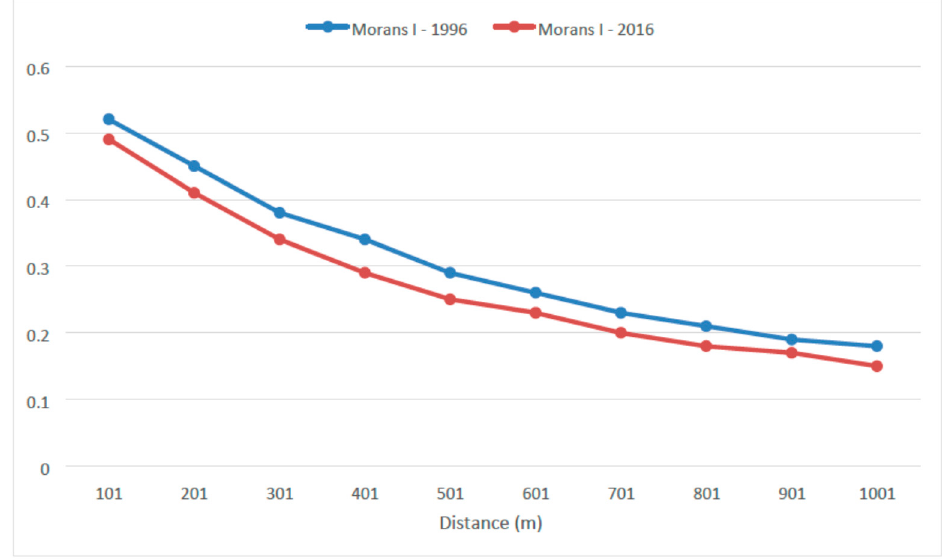
Figure 7. Moran’s I index for fire hazard (1996 and 2016) in relation to distance.